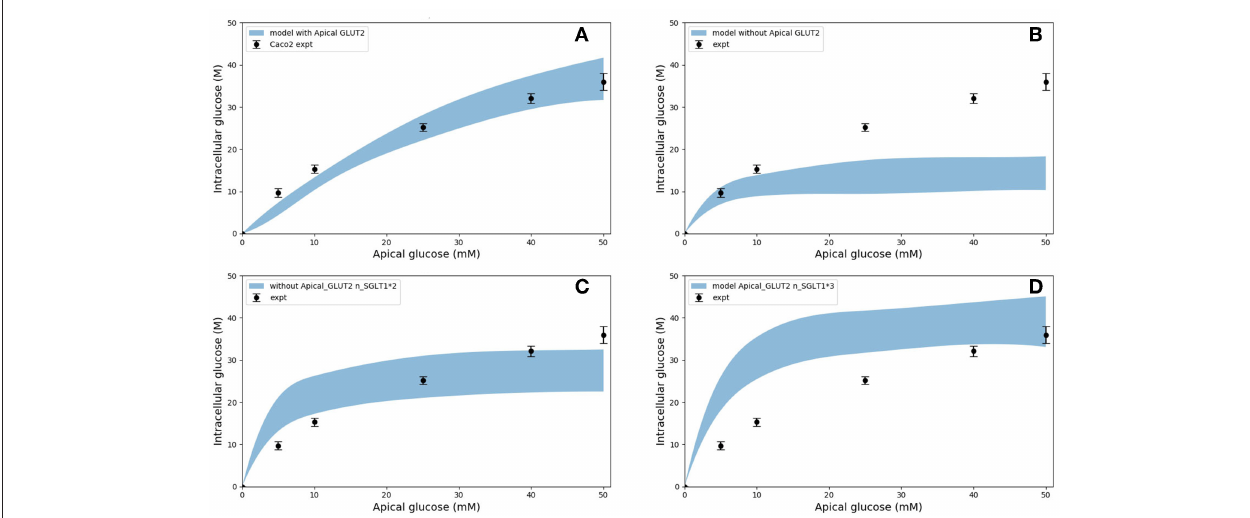
FIGURE 6 | Intracellular glucose concentration vs. extracellular glucose concentration in Caco2 in the presence/absence of Apical GLUT2 with different number of SGLT1 transporter (A) Output of model with apical GLUT2 (B) Model does not have apical GLUT2 (C) model does not have apical GLUT2 and the number of SGLT1 is doubled (D) model does not have apical GLUT2 and the number of SGLT1 is 3-fold higher. Experimental data points and error bars were digitally extracted from Zheng et al. (2012). Strips for the model predictions represent the range of values generated by setting V b = mV c , m = 0.1,1,10,100, ∞ .